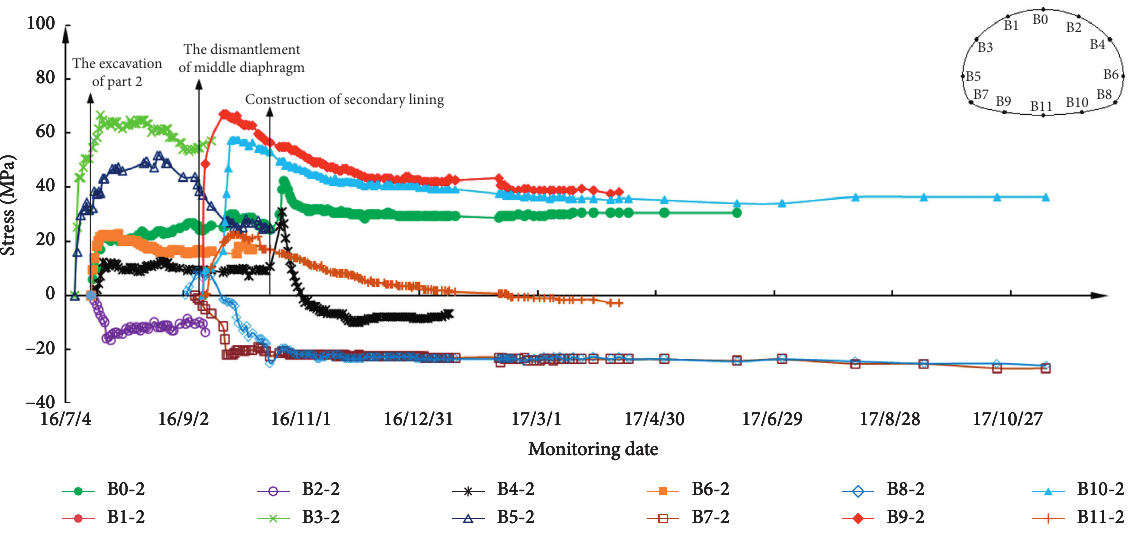
Figure 15: The inside stress curves of steel rib in YK2+133